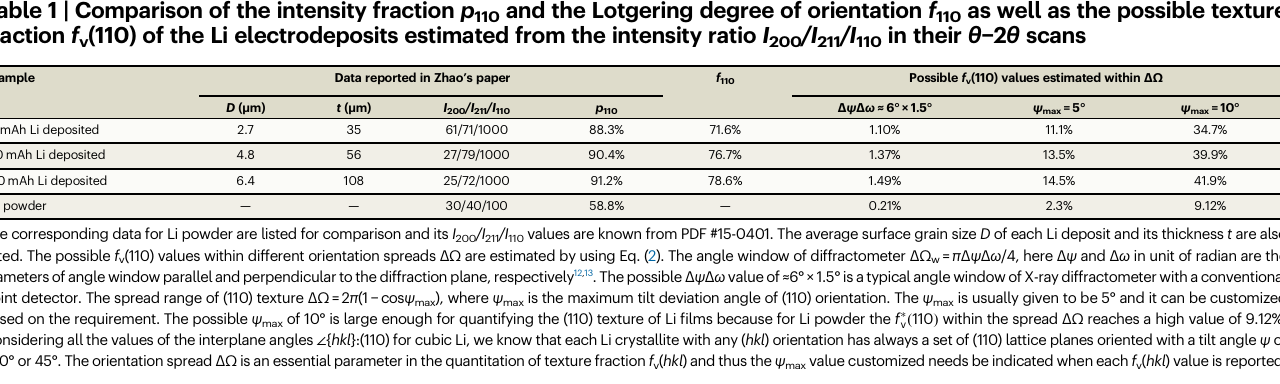
Table 1 | Comparison of the intensity fraction p 110 and the Lotgering degree of orientation f 110 as well as the possible texture fraction f v (110) of the Li electrodeposits estimated from the intensity ratio I 200 /I 211 /I 110 in their θ − 2 θ scans Sample